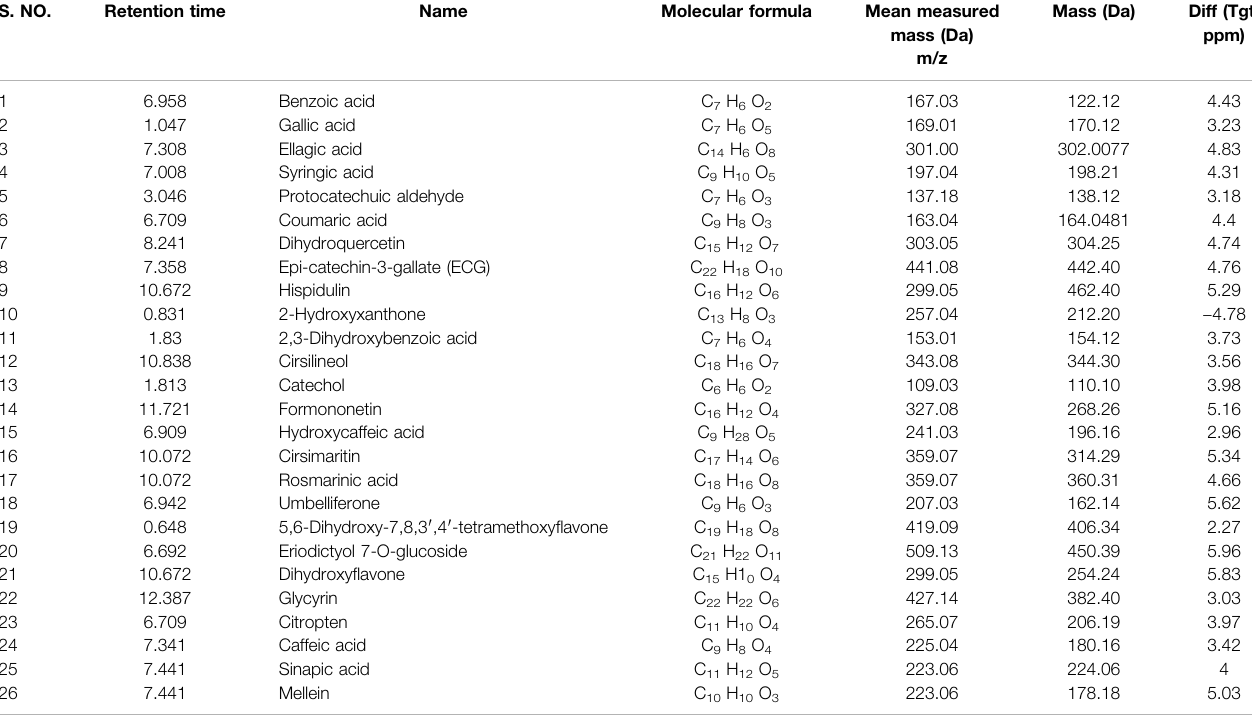
TABLE 3 | QTOF-ESI-MS data of identi fi ed plant metabolites from fraction F1 in negative mode [M − H] − with a possible molecular formula. S.